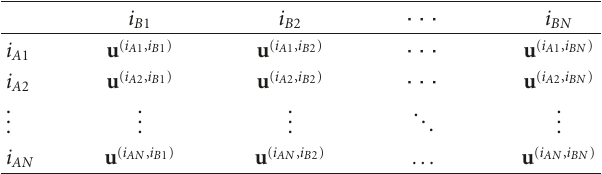
Table 1: Example of hierarchical codeword table ( | B A | = | B B | = N ).